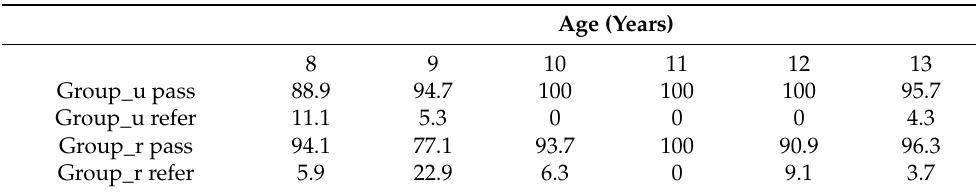
Table 3. Percentage of normal hearing threshold (pass) and hearing loss (refer) by age and area of